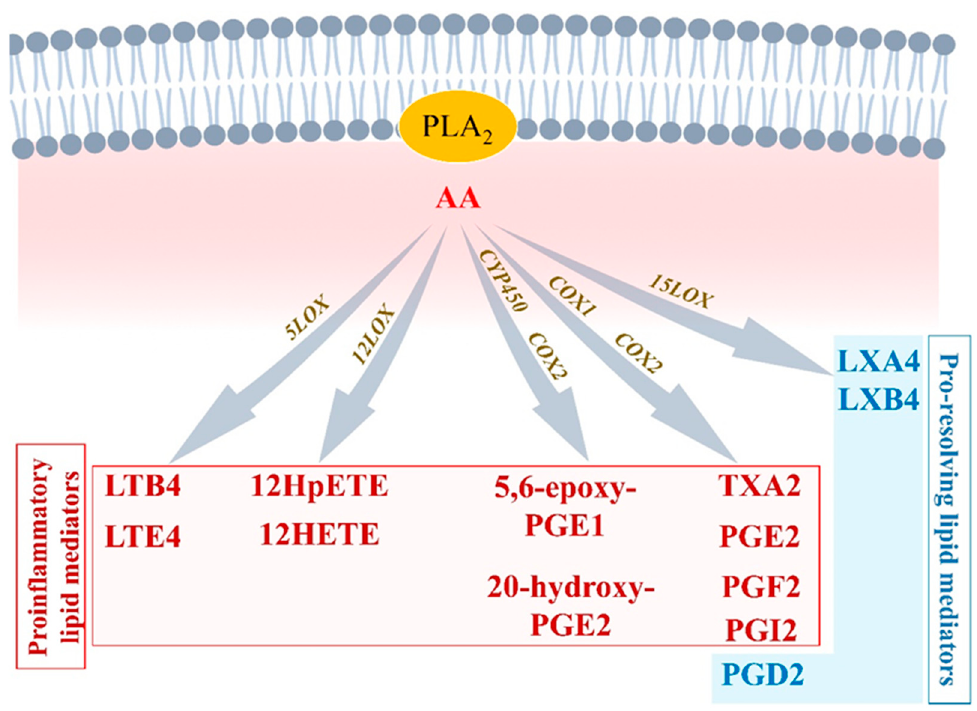
Figure 2. Arachidonic acid-derived lipid mediators. Arachidonic acid (AA) interaction with COX1, COX2, 5LOX, 12LOX, or CYP450 enzymes mainly leads to the production of proinflammatory lipid mediators including leukotrienes, thromboxanes, and prostaglandins. AA interaction with COX1/2 or 15LOX can generate pro-resolution mediators including PDG2, LXA4, and LXB4.